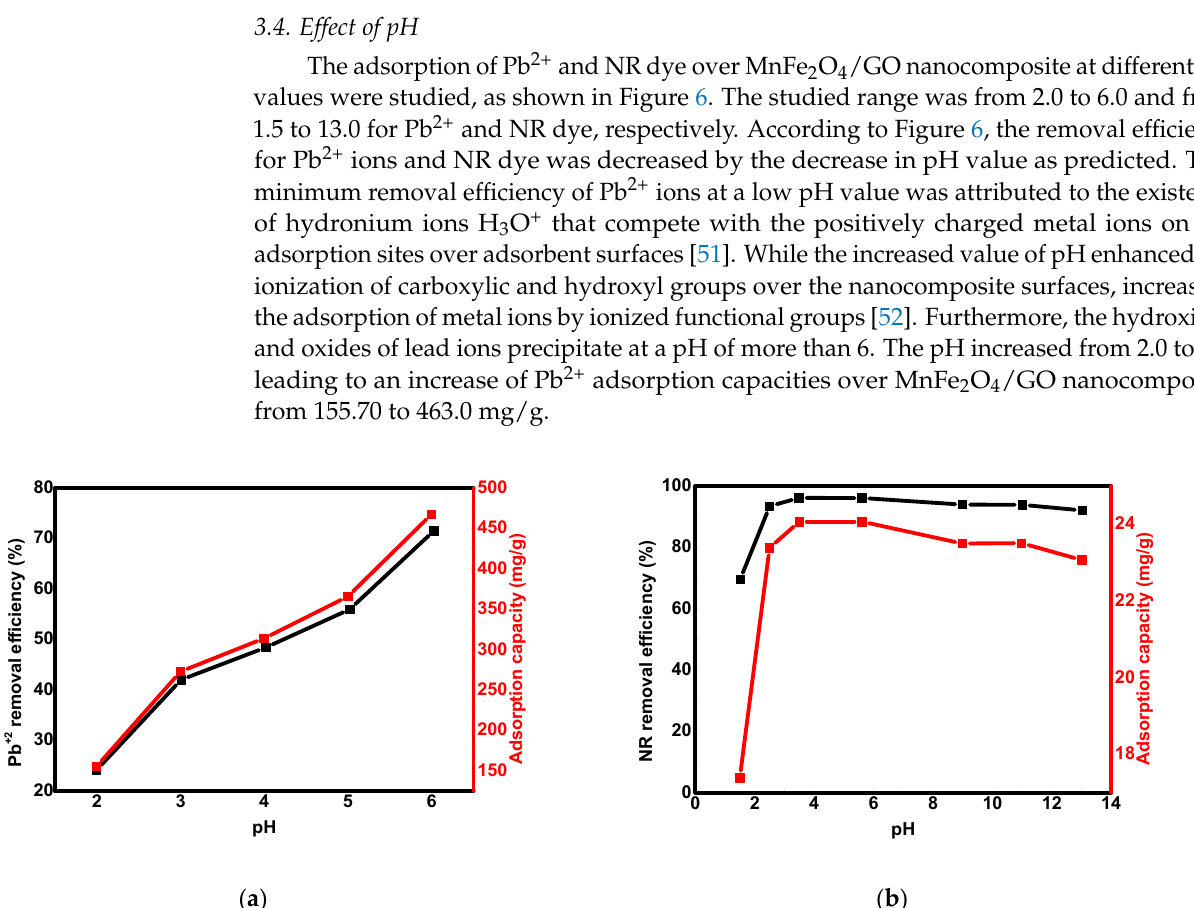
MnFe 2 O 4 /GO nanocomposite was